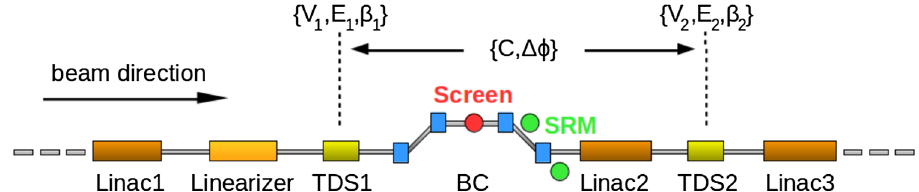
FIG. 1. Layout of a reversible electron beam heater system including two transverse deflecting rf structures located upstream and downstream of a magnetic bunch compressor (BC) chicane, and longitudinal phase space diagnostics using screens and synchrotron radiation monitors. Parameters related to the reversible beam heater system are denoted in curly